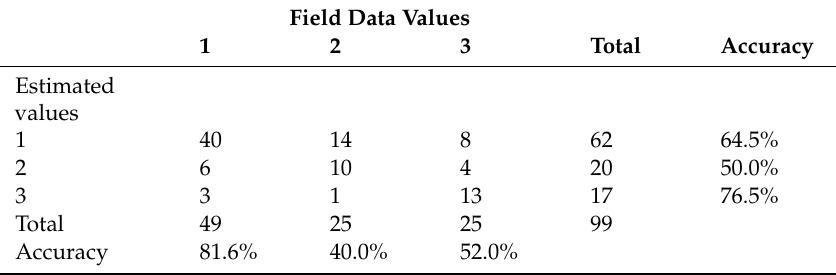
survey mean field data values versus values estimated from the ALS linear discriminant